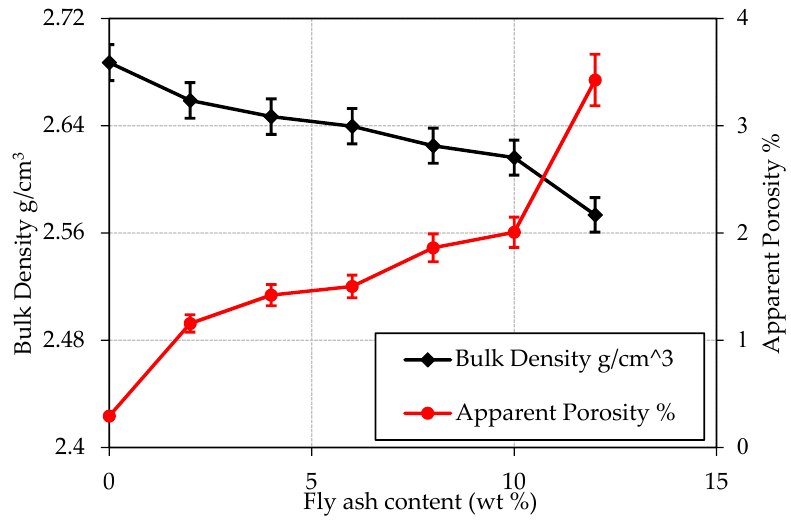
Figure 7. Bulk density and apparent porosity of AA6063 ‐ FA composites as a function of fly ash percentage content.